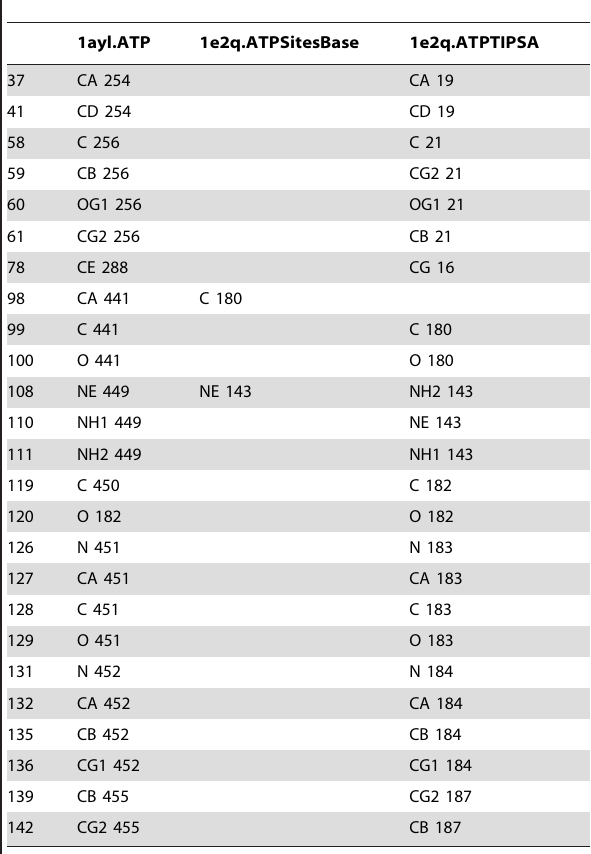
Table 11. Matched atoms from the ATP binding site of 1ayl and ATP binding site of 1e2q found only by either SitesBase or